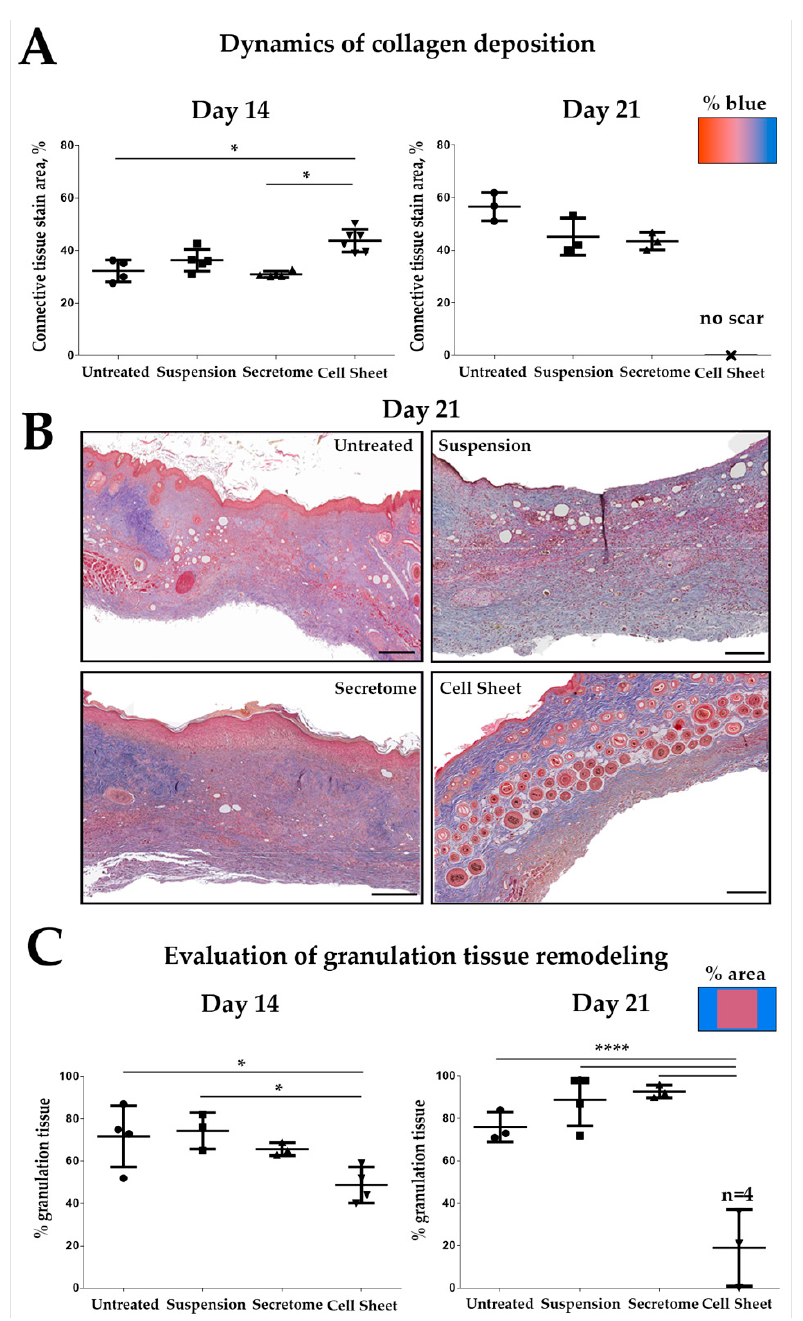
Figure 2. Histological assessment of granulation tissue (GT) remodeling in experimental groups. ( A ) Relative content of collagen and reticular fibers (% of defect); ( B ) healing of skin and its appendages at the site of pressure ulcer in the “Cell Sheet” group (Day 21); Masson’s trichrome, scale bar represents 200 µm; ( C ) assessment of granulation tissue remodeling by calculation of its relative area (% of section area); n = 4 denotes number of animals assessed at this point, of which 3 had no GT area to account for while 1 had minimal remaining GT which allow presenting statistics (*— p < 0.05; ****— p < 0.0001).